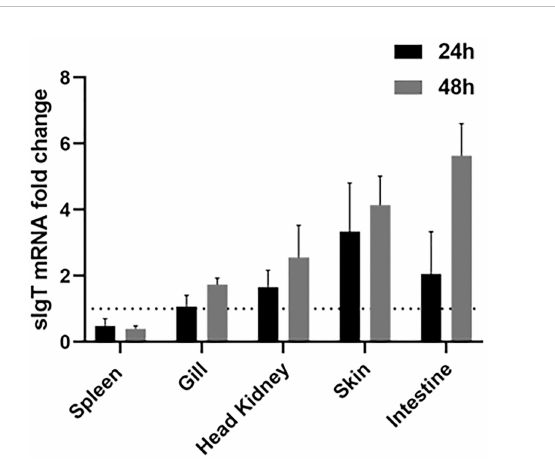
FIGURE 7 IgT expression in ASB mucosal tissues after exposure to NNV. Modulation of IgT mRNA levels in fi ve tissues of six ASB (spleen, gill, skin, head kidney and intestine) 24 h and 48 h after RGNNV immersion. Total RNA from various tissues was isolated and transcribed into cDNA followed by detection of IgT expression using real-time PCR. IgT gene expression was calculated using the 18S RNA as a reference gene and the fold change in IgT mRNA expression level was normalized by comparison to the control group. Data were expressed as the mean ± SE. Dotted line represents the baseline of non-challenged fi